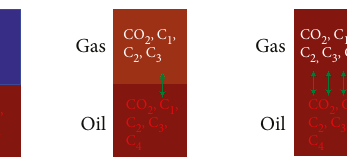
Figure 1: Basic theory of state equation.